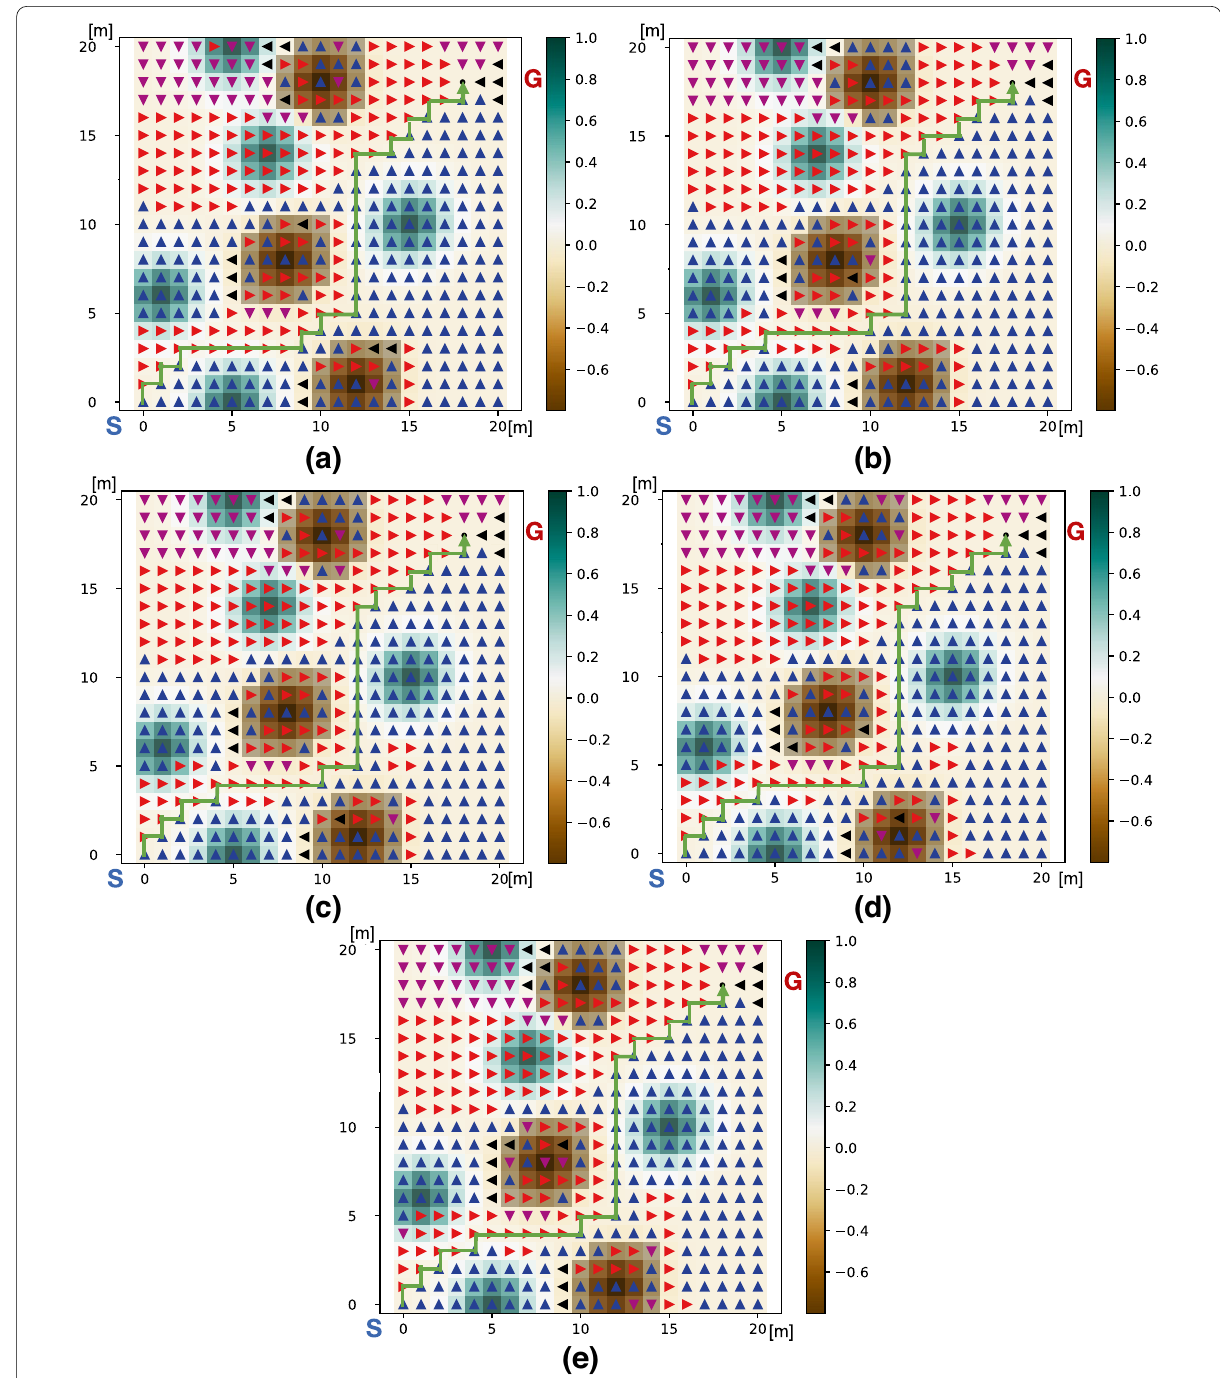
Fig. 5 The path planning results on hard gorund (2); a : ( w 1 , w 2 ) = ( 0.6,0.4 ) , b : ( w 1 , w 2 ) = ( 0.7,0.3 ) , c : ( w 1 , w 2 ) = ( 0.8,0.2 ) , d : ( w 1 , w 2 ) = ( 0.9,0.1 ) , e : ( w 1 , w 2 ) = ( 1,0